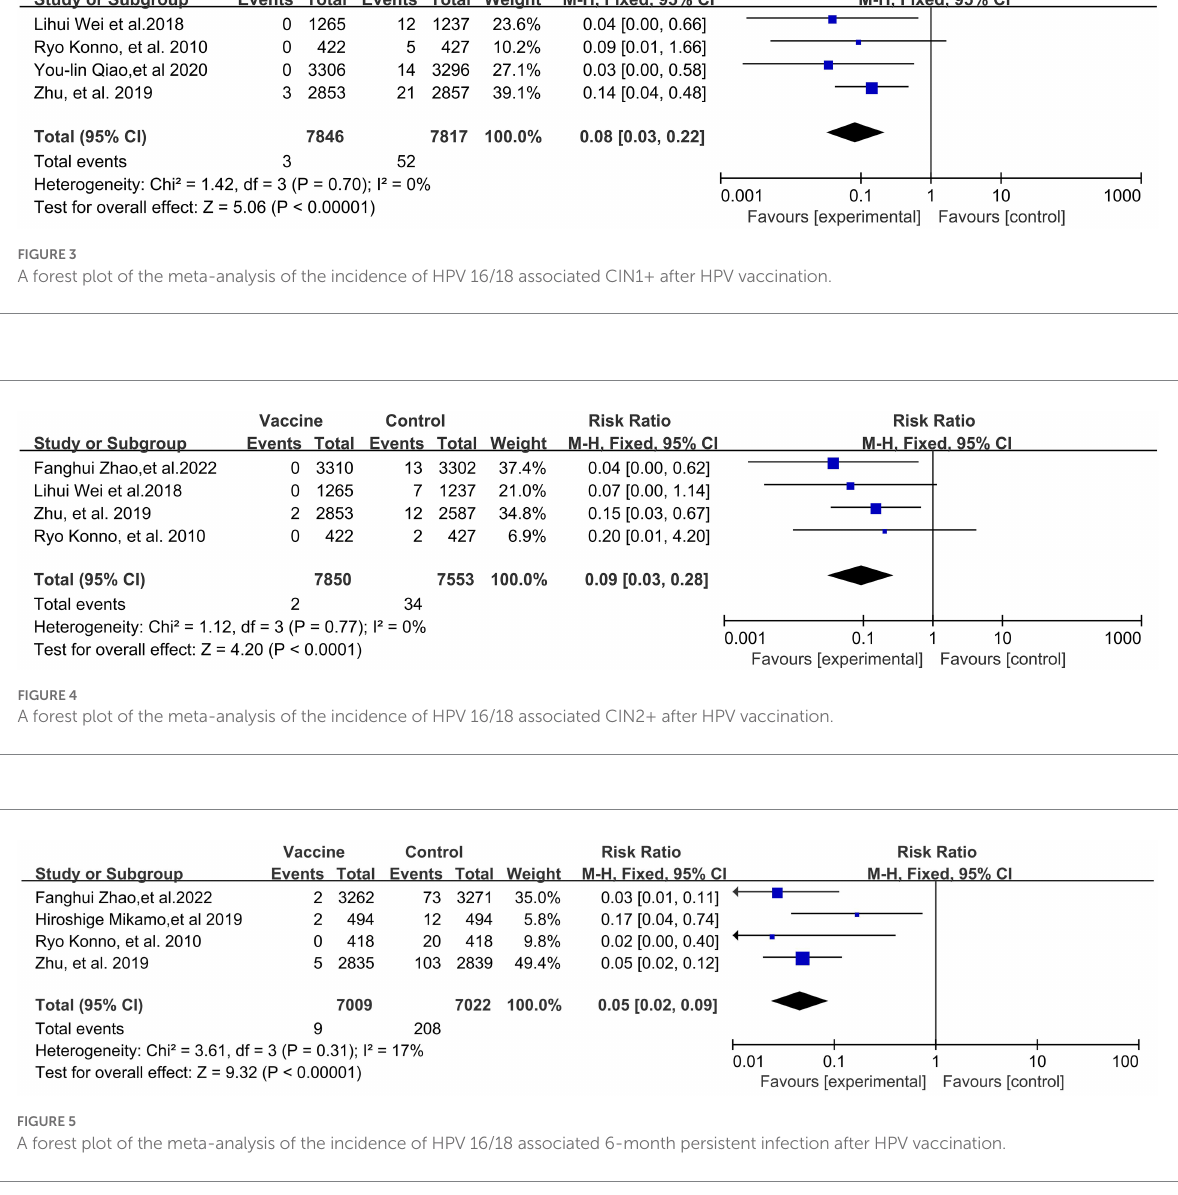
0.03–0.28). No significant heterogeneity was observed among the involved studies (I 2 = 0%; p = 0.77).